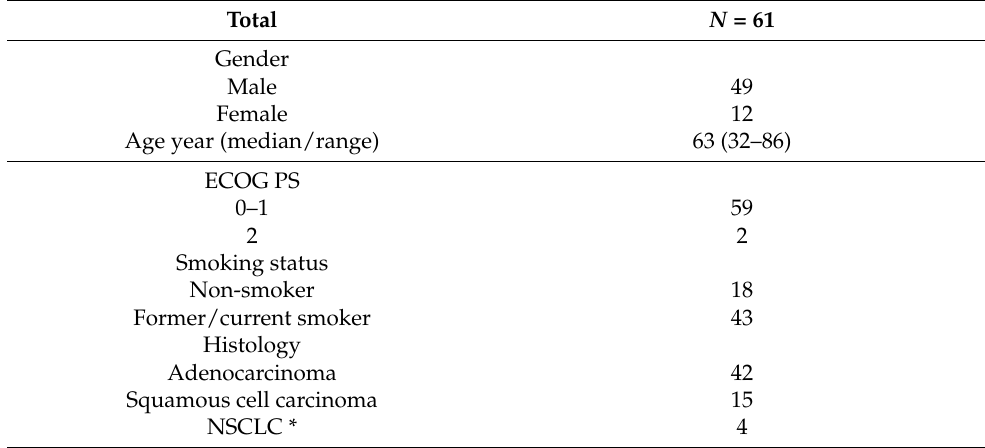
Table 1. Baseline demographic and treatment information of all